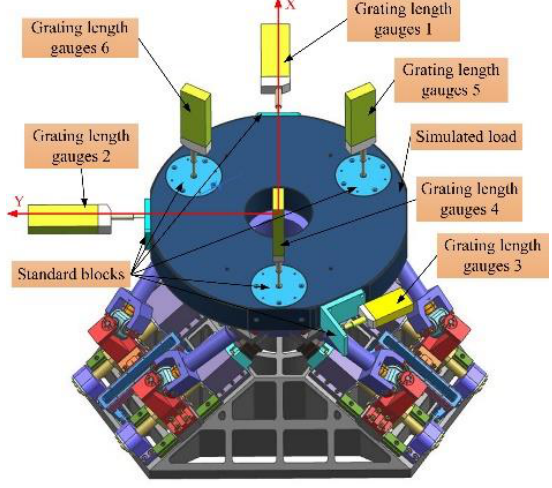
Figure 22. Definition of the coordinate system for the parallel platform and layout of the grating length